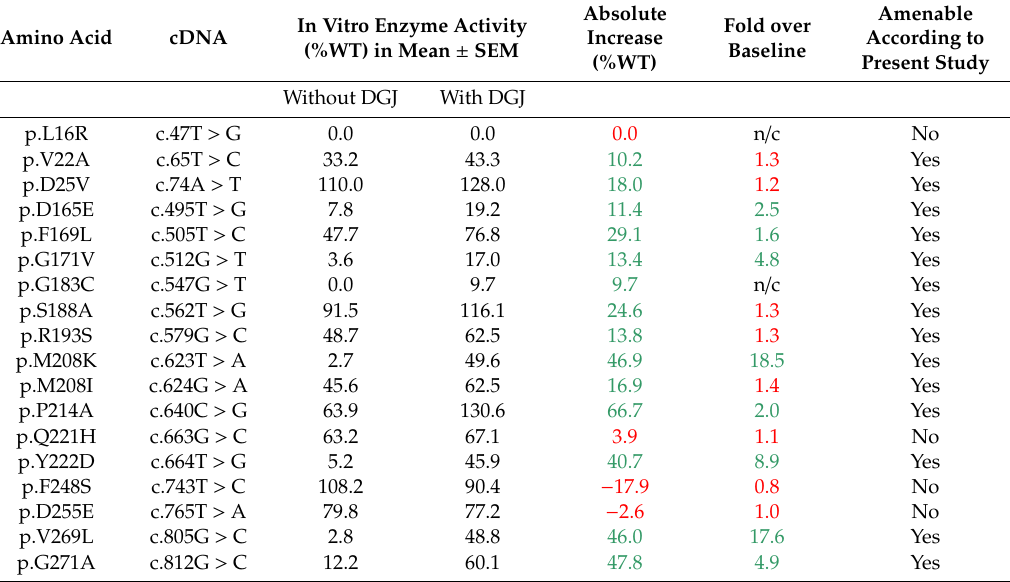
Table 4. Enzyme activity and DGJ amenability classification of 18 novel GLA gene